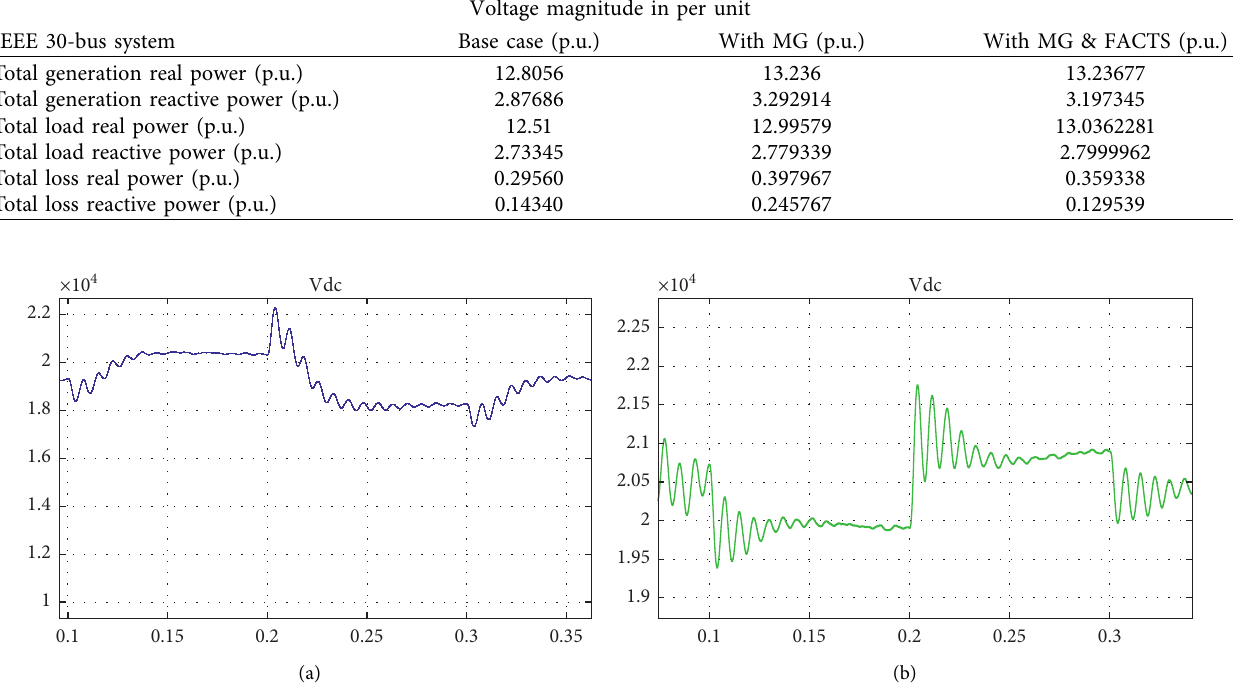
Figure 12: The DC voltage with (a) PI control and (b) fuzzy-PI control.